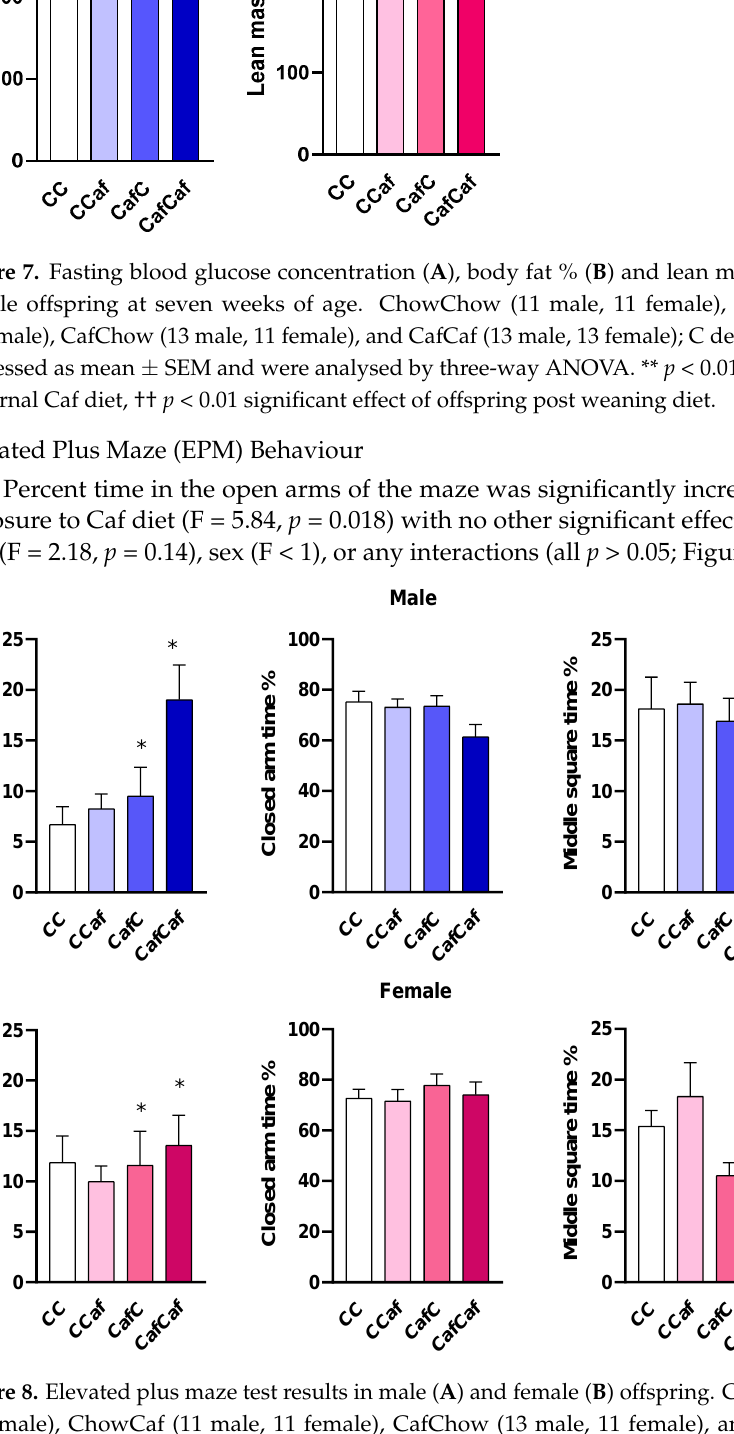
Figure 8. Elevated plus maze test results in male ( A ) and female ( B ) offspring. ChowChow (11 male, 11 female), ChowCaf (11 male, 11 female), CafChow (13 male, 11 female), and CafCaf (13 male, 13 female); C depicts chow. The percentage of time spent in open and closed arms, and in the middle square were determined for each animal over a 5 min session. Data are expressed as mean ± SEM and were analysed by three-way ANOVA. * p < 0.05 significant effect of maternal Caf diet. Place/object test Behaviour Our results showed no significant effect of maternal or offspring diet on object or